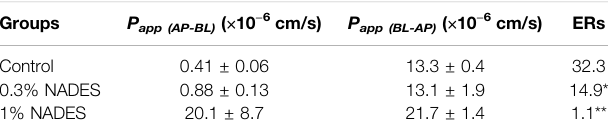
TABLE3| In fl uencesofthenaturaldeepeutecticsolvent(NADES)ontheapparent permeability ( P app ) and ef fl ux rates (ERs) of berberine hydrochloride in MDCK- MDR1 cells (Mean ± SD, n (cid:2)